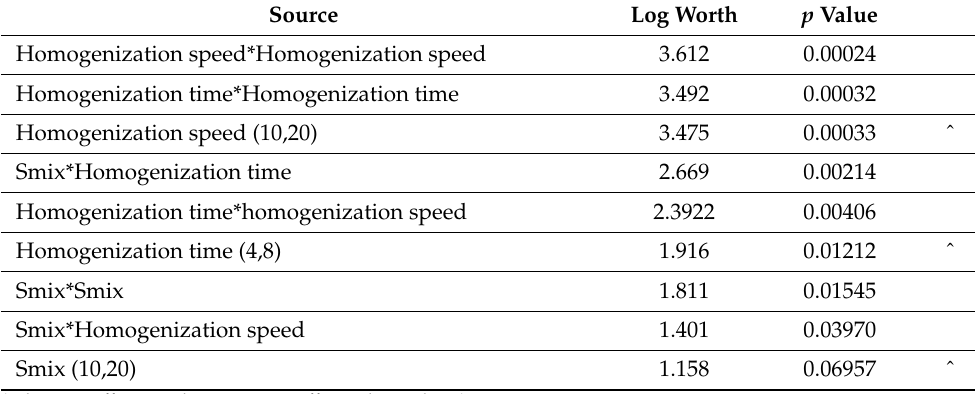
Table 1. Effect Summary of factors and observed responses for MeHCl + TMPS SLNs.